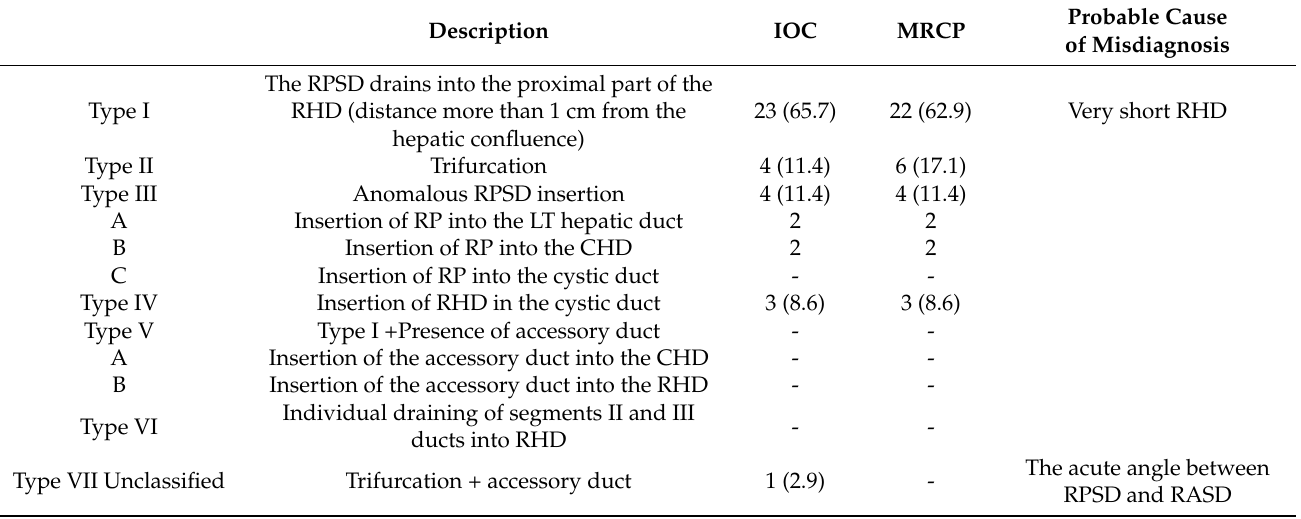
Table 2. The intrahepatic biliary anatomy based on 2D and 3D MRCP and